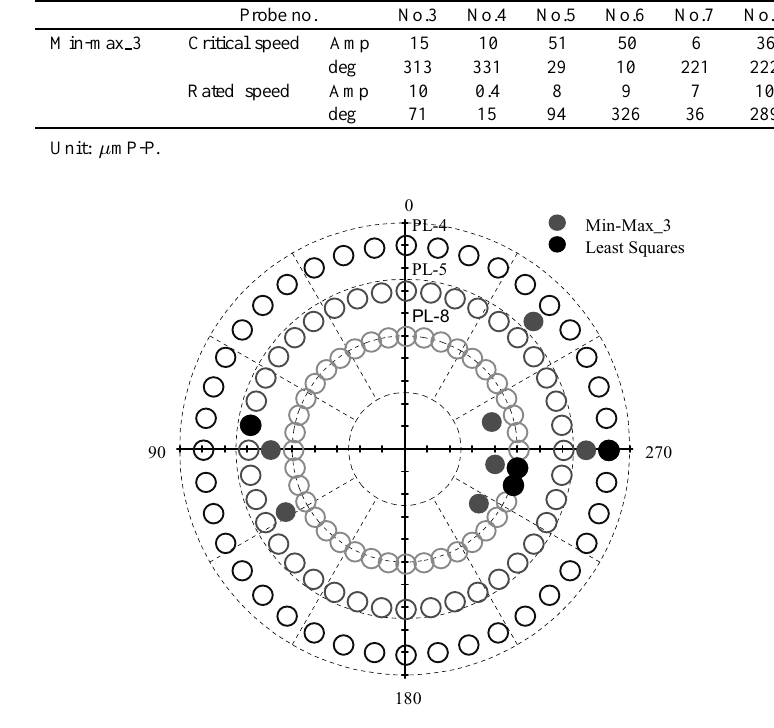
Fig. 6. Comparison of balance weight